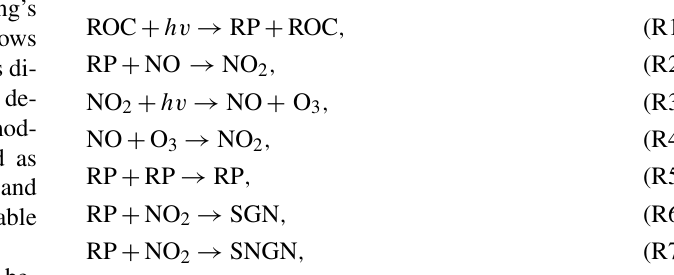
Fig. 2. Modified L MO values from 16:00 to 19:00 are